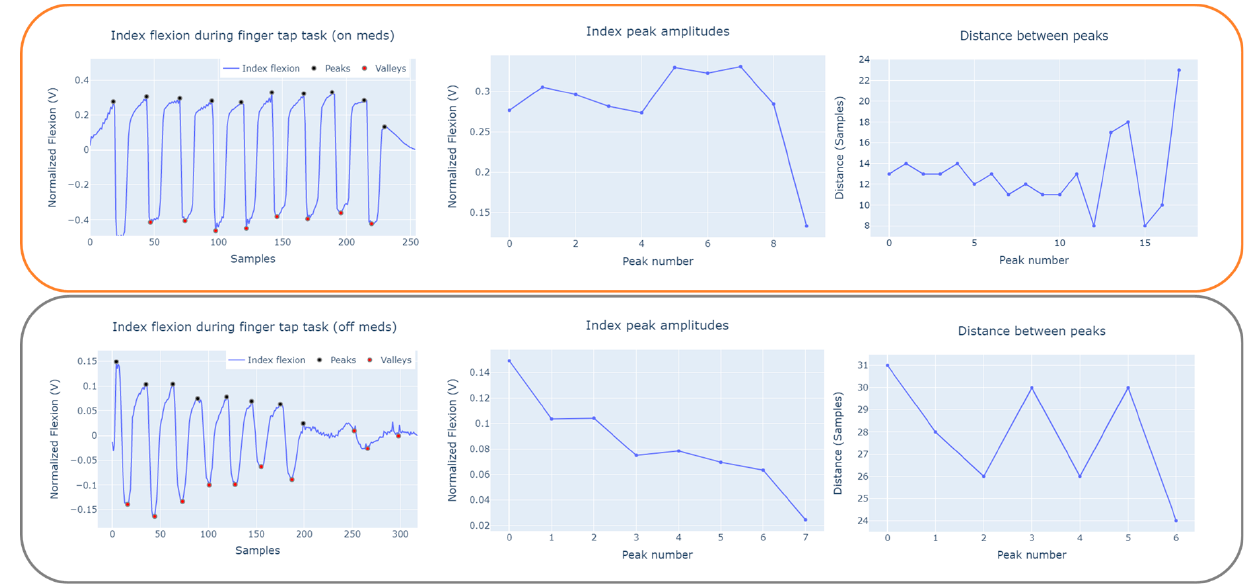
Figure 9. Case plot of right index flexion amplitude and tap interval obtained based on peak-valley analysis for pre- and post-medication states.